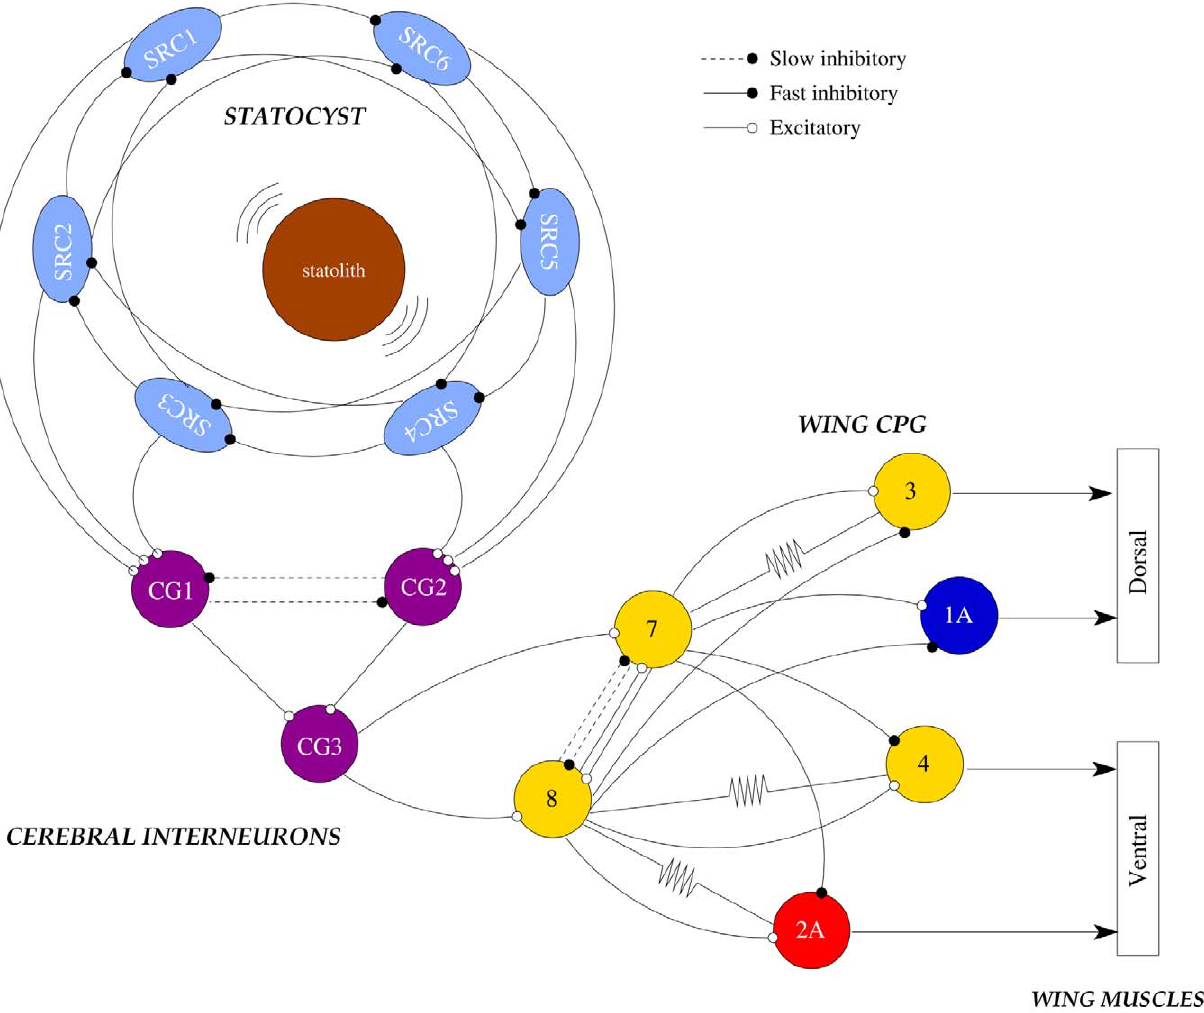
Figure 5. Statocyst model connected to a wing CPG model. Statocyst dynamics drive the motoneurons that control the movement of the wings. Here we have modeled the wing CPG circuit by building a network with six neurons: 7, 8, 1A, 2A, 3 and 4. This network replicates the known wing CPG connectivity [20,42]. Each single neuron represents the equivalent electrically coupled groups of cells in the biological circuit. We have chosen neurons 1A (for the dorsal group) and 2A (for the ventral) as representative cells of the CPG behavior. The statocyst is connected to this CPG through a simple model of cerebral cells that consists of three cerebro-pedal interneurons (CG1-3). Note that we omitted the hunting neuron in the statocyst circuit diagram to simplify the graphical